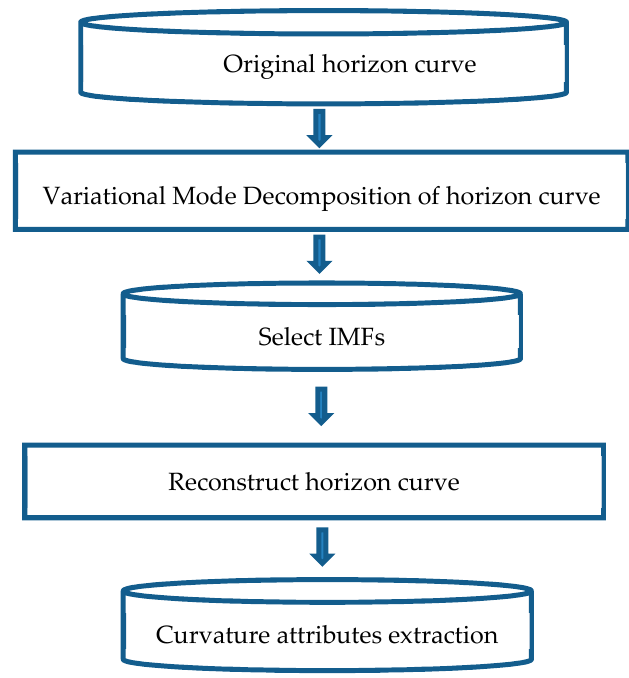
Figure 2. Flow chart of curvature attributes extraction based